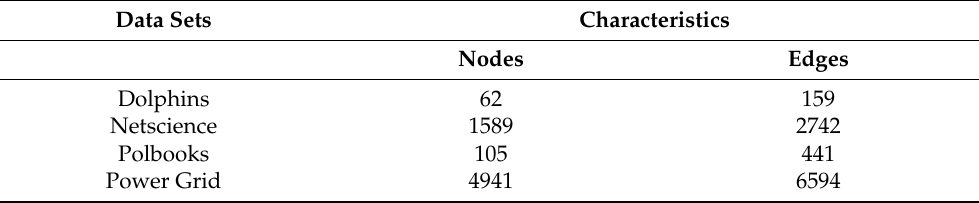
Table 4. Attributes of the benchmark datasets.